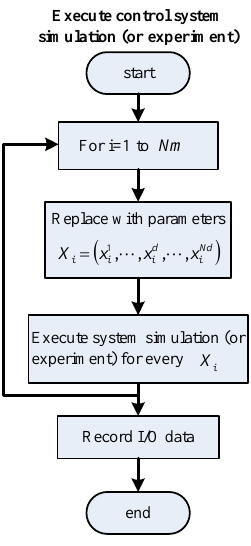
Figure 5. Flowchart for executing the control system simulation (or experiment). Sensors 2015 , 15 , page–page